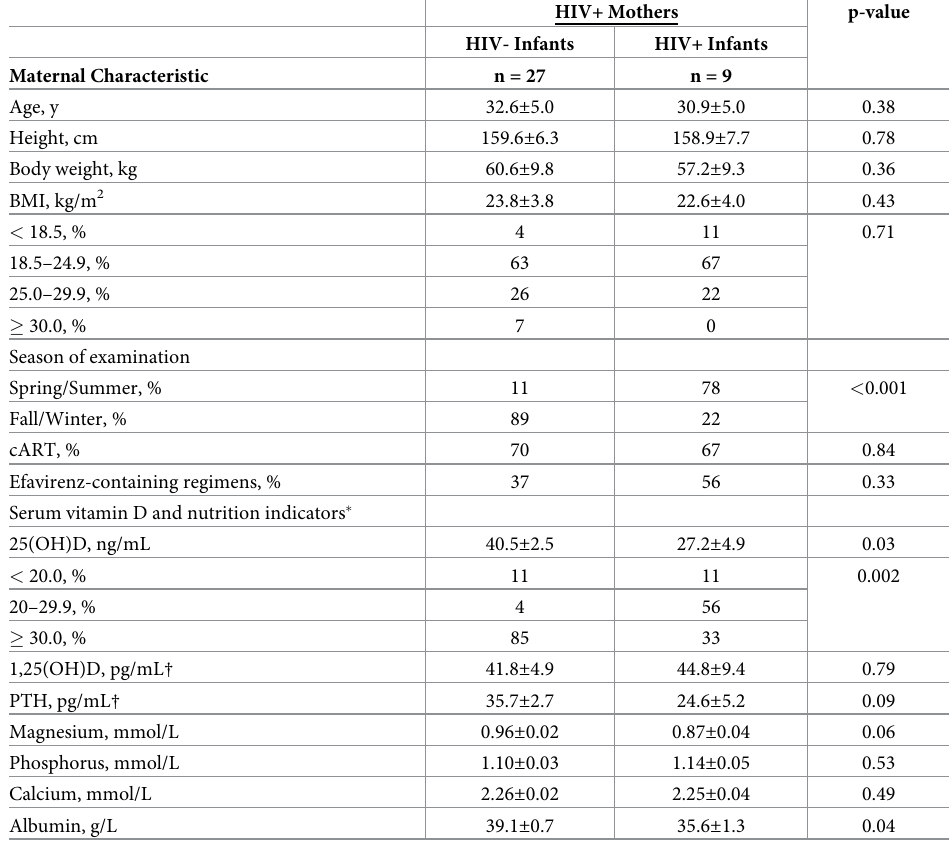
Table 1. Maternal characteristics of HIV positive mothers (n = 36) stratified by HIV status of their infants.